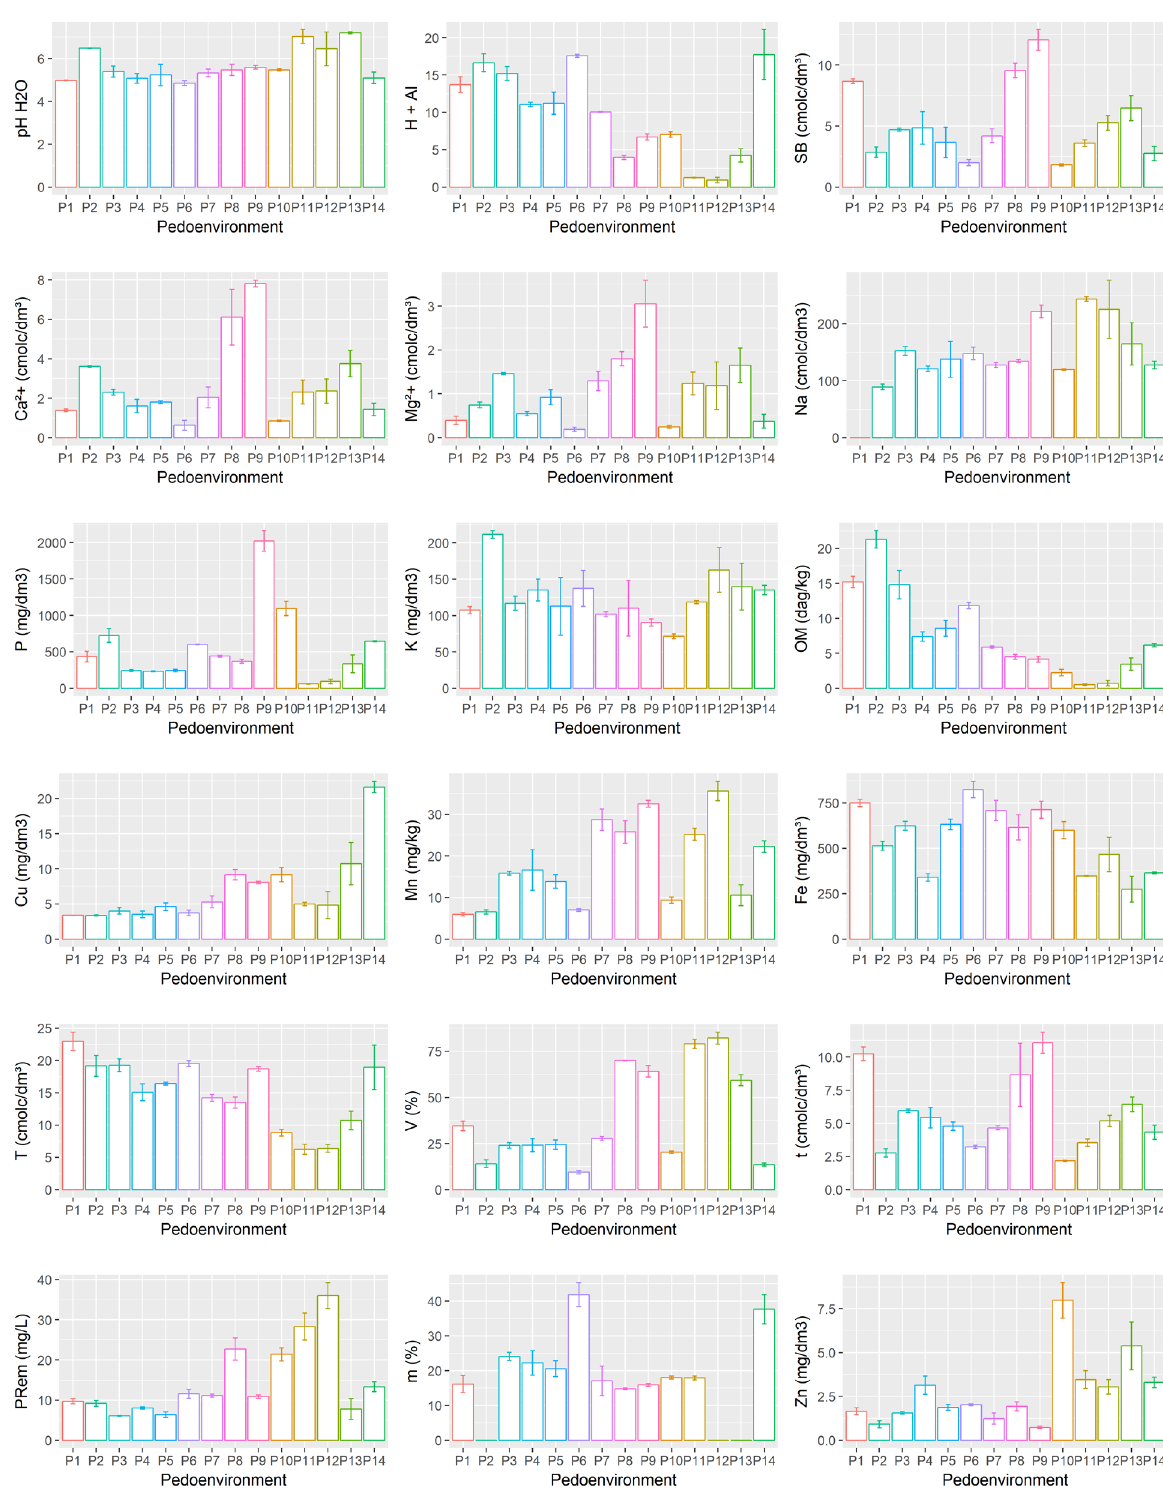
Figure 2. Barplots soil properties. For analysis, available: pH (H exchangeable bases (SB), Ca 2+ , Mg 2+ , Na, P, K, organic matter (OM), Cu, Mn, Fe, potential cation exchange capacity (T), percentage of bases saturation (V), effective cation exchange capacity (t), Remaining phosphorus (P Rem), Al saturation (m) and Zn, were